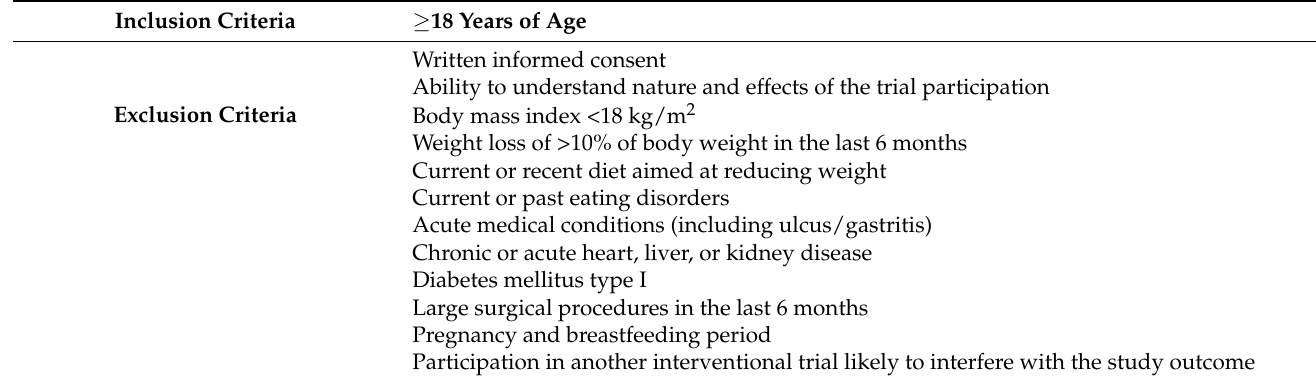
Table 1. Inclusion and exclusion criteria of the